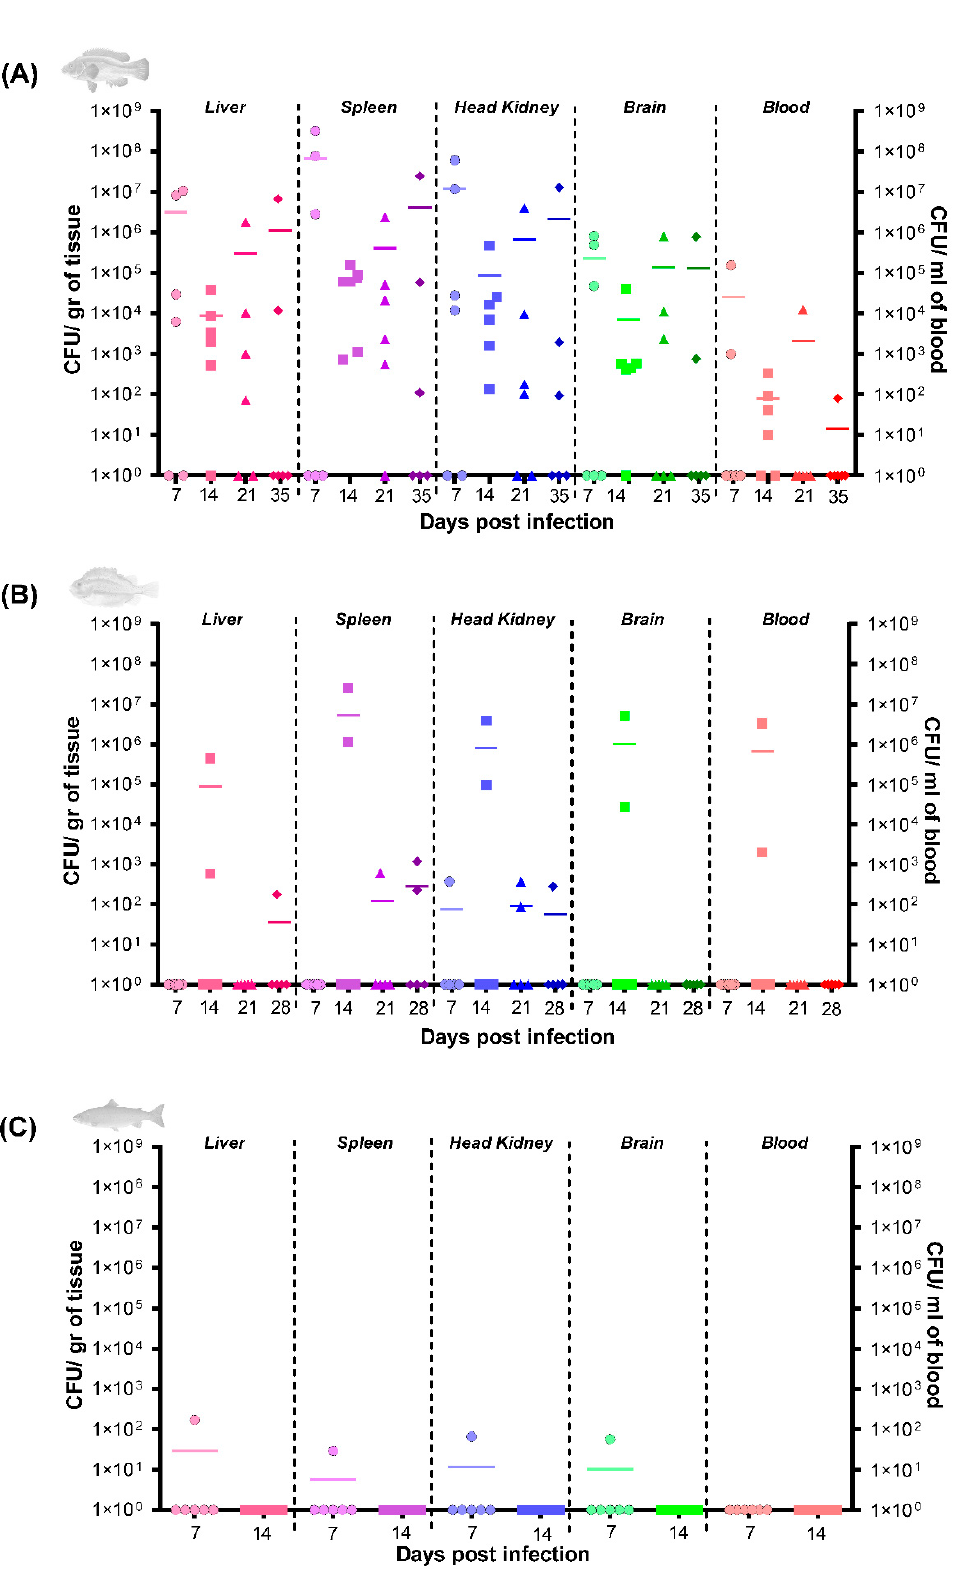
Figure 3. Pseudomonas sp. strain J380 demonstrates host-specific infection kinetics and tissue colonization in different hosts, including ( A ) Cunners ( Tautogolabrus adspersus ; n = 6/time point) ( B ) Lumpfish ( Cyclopterus lumpus ; n = 5/time point), and ( C ) Atlantic salmon ( Salmo salar ; n = 6/time point). For challenge details, refer to Figure 2. The symbols represent different sampling time points: circle, 7 dpi; square, 14 dpi, triangle, 21 dpi; rhomboid, 28 or 35 dpi.